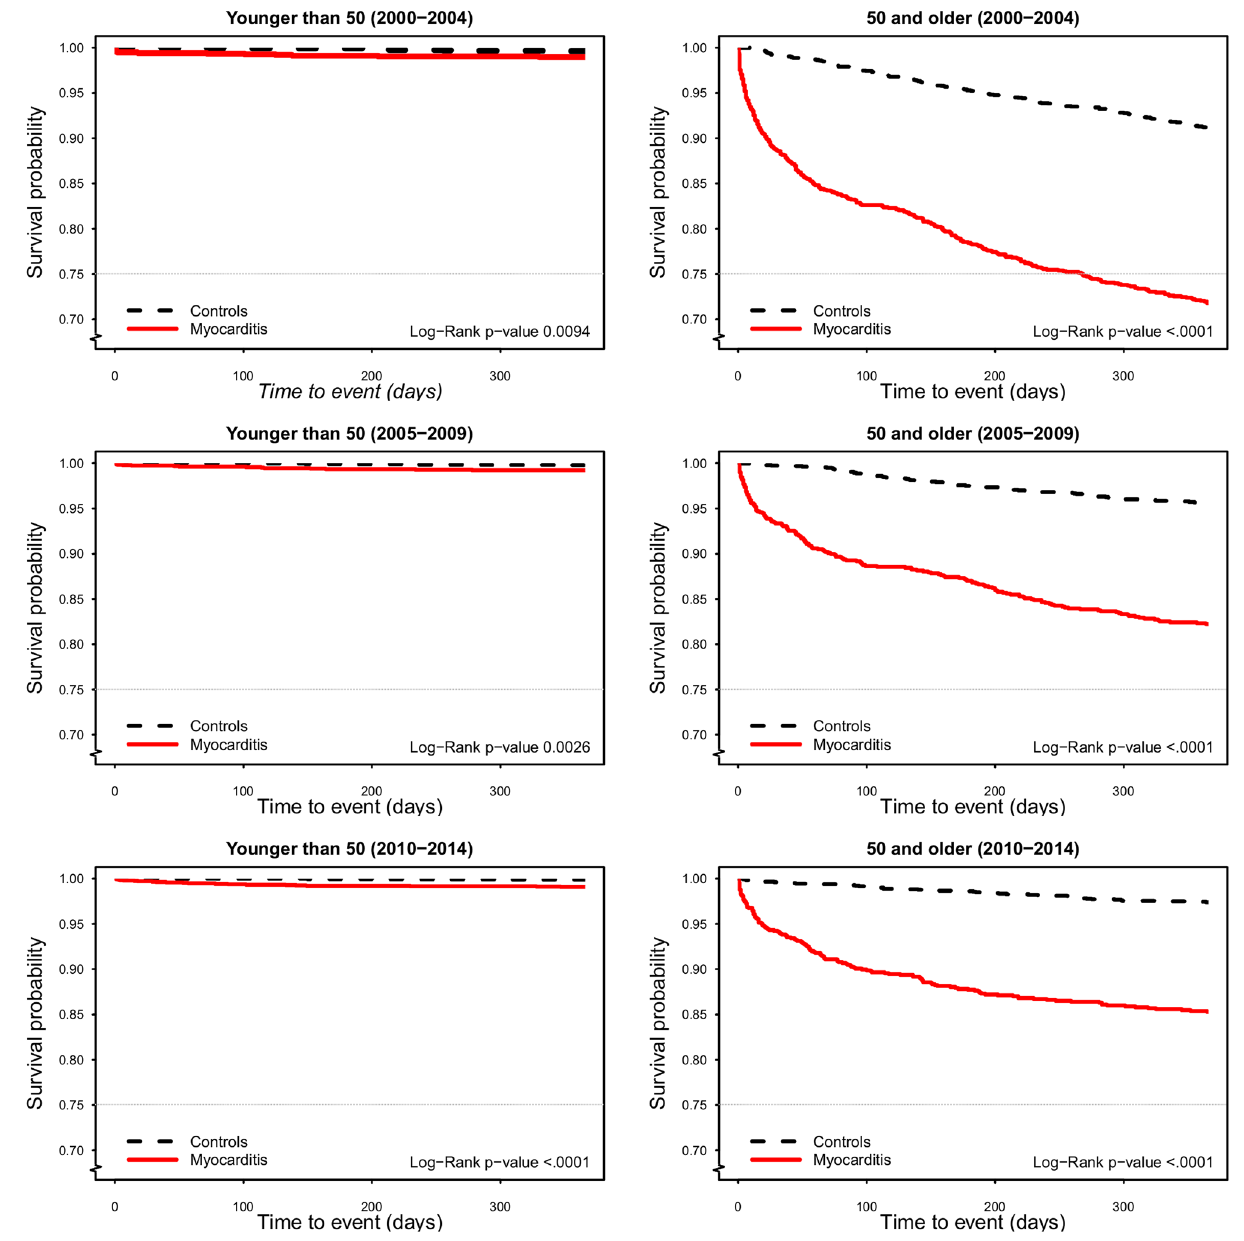
Figure 4. 1-year mortality from 2000 to 2014 stratified by age: < 50 and ≥ 50